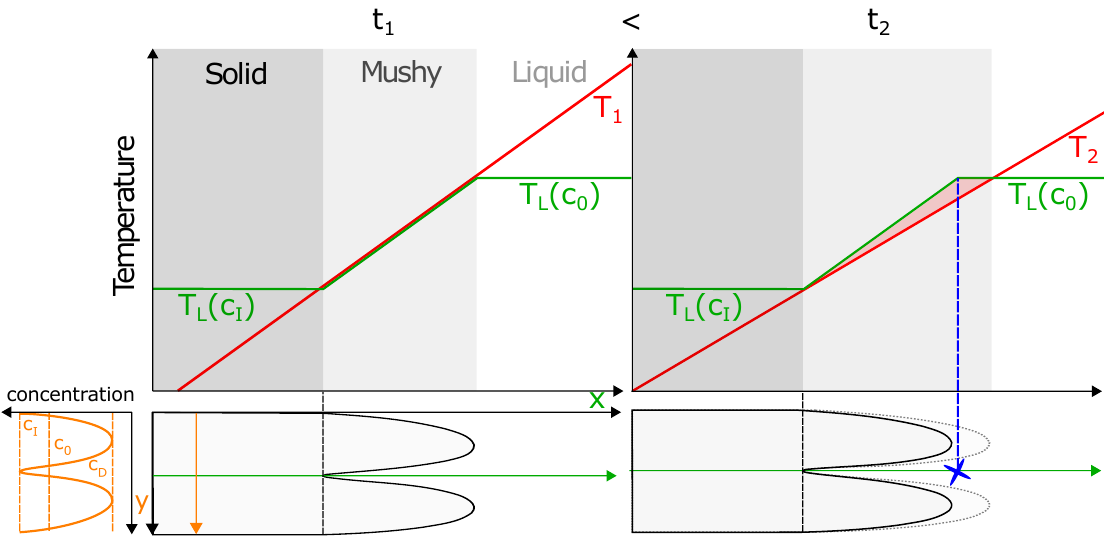
Figure 11. Schematic representation of liquidus temperature T L and current temperatures ( T 1 and T 2 ) at turning point from melting to solidification (time t 1 ) and shortly after solidification started (time t 2 ). Due to a concentration gradient in the mushy zone, a constitutional undercooled region occurred where nucleation could happen. Former concentration distribution in solid with nominal concentration c 0 , maximal concentration in former interdendritic regions c I , and minimal concentration in former dendrite cores c D are